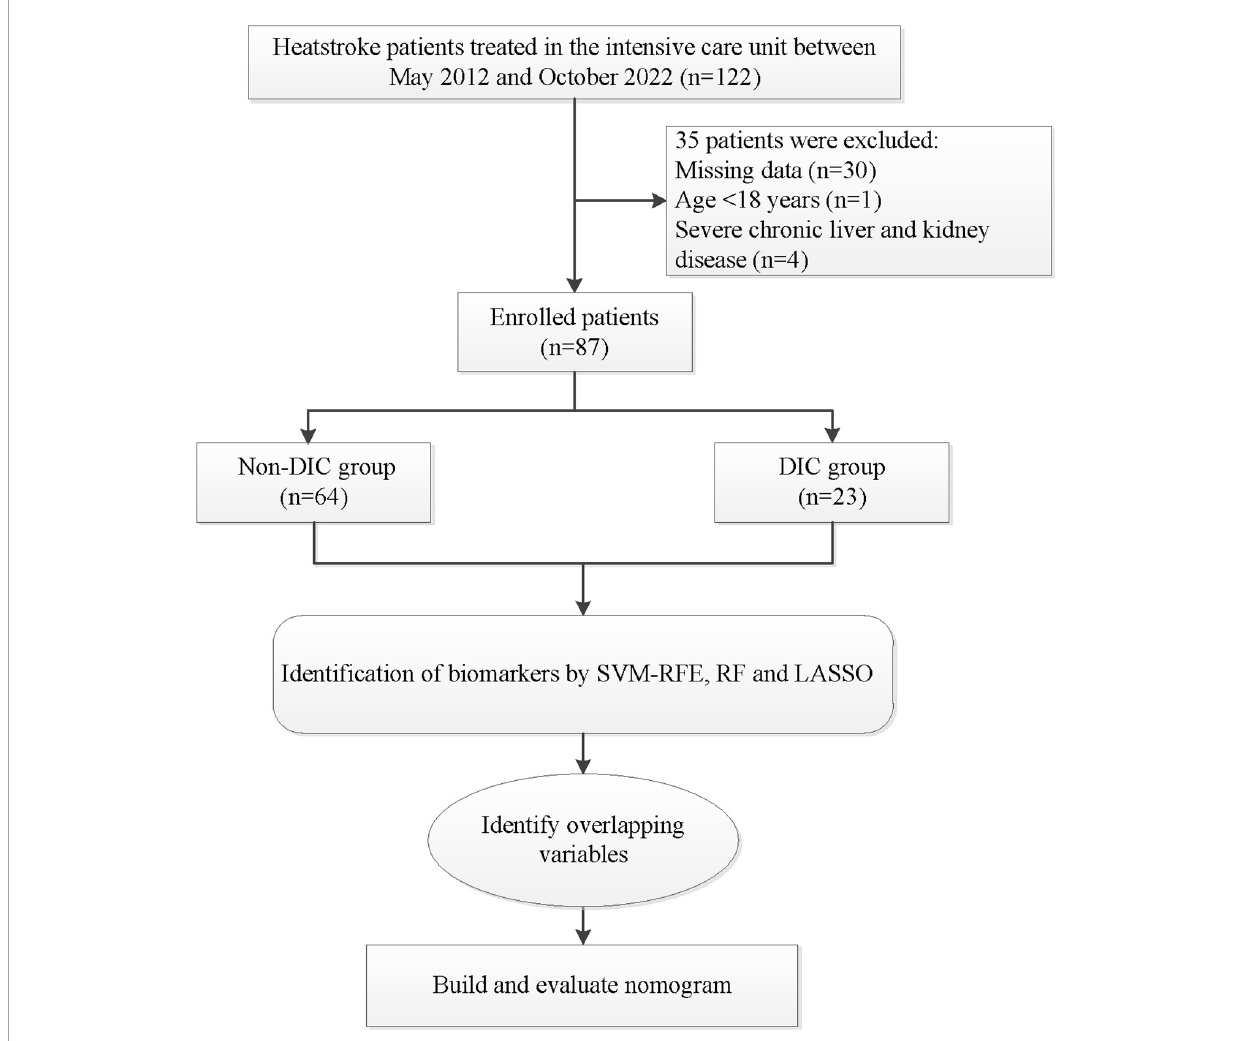
FIGURE1 Flowchart of patient selection and analysis. DCA, decision curve analysis; LASSO, least absolute shrinkage and selection operator; RF, random forest; SVM-RFE, support vector machine-recursive feature